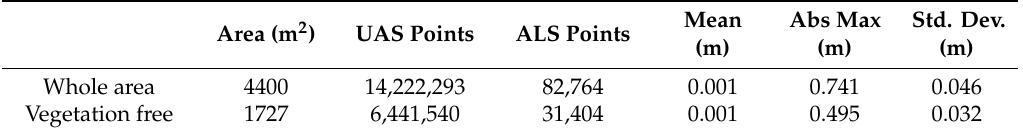
Table 6. SfM vs. ALS large